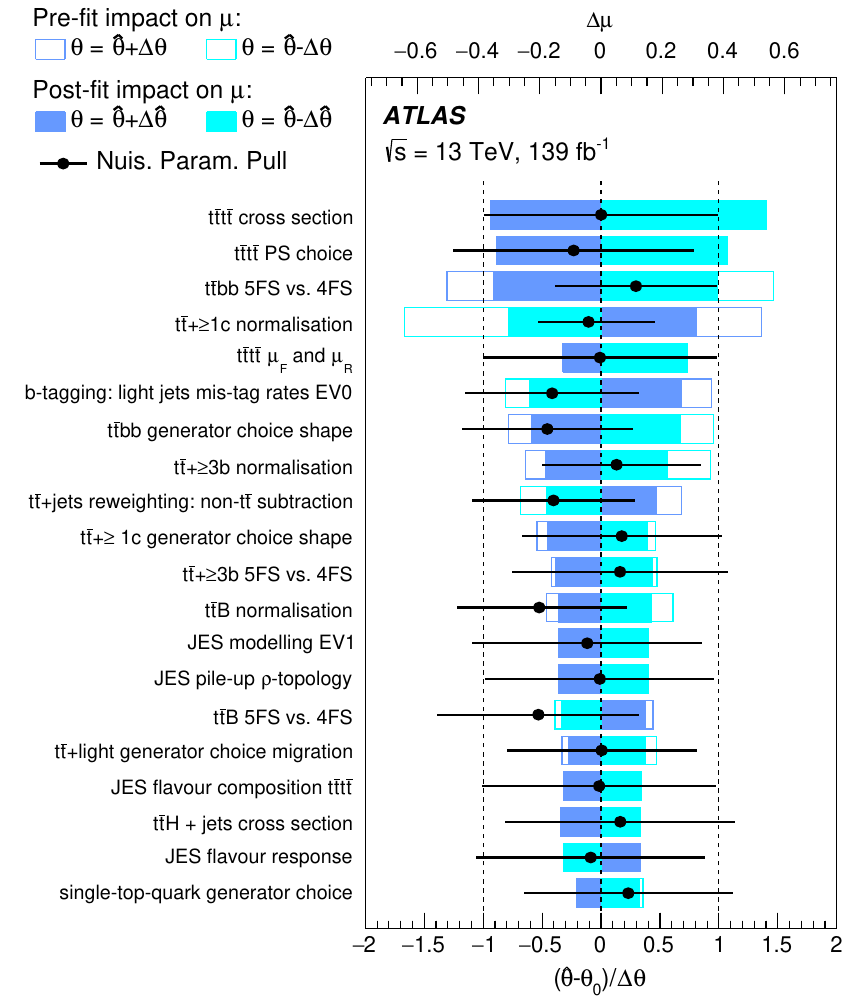
Figure 11 . The nuisance parameters ranked according to their post-fit impacts on the best-fit value of µ . Only the 20 nuisance parameters with the largest impacts are shown. The empty (solid) blue rectangles illustrate the pre-fit (post-fit) impacts on the parameter of interest µ , corresponding to the top axis. The pre-fit (post-fit) impact of each nuisance parameter, ∆ µ , is calculated as the difference in the fitted value of µ between the nominal fit and the fit when fixing the corresponding nuisance parameter to ˆ θ ± ∆ θ ( ˆ θ ± ∆ˆ θ ), where ˆ θ is the best-fit value of the nuisance parameter and ∆ θ ( ∆ˆ θ ) is its pre-fit (post-fit) uncertainty. The black points show the best-fit values of the nuisance parameters, with the error bars representing the post-fit uncertainties. Each nuisance parameter is shown relative to its nominal value, θ , and in units of its pre-fit 0